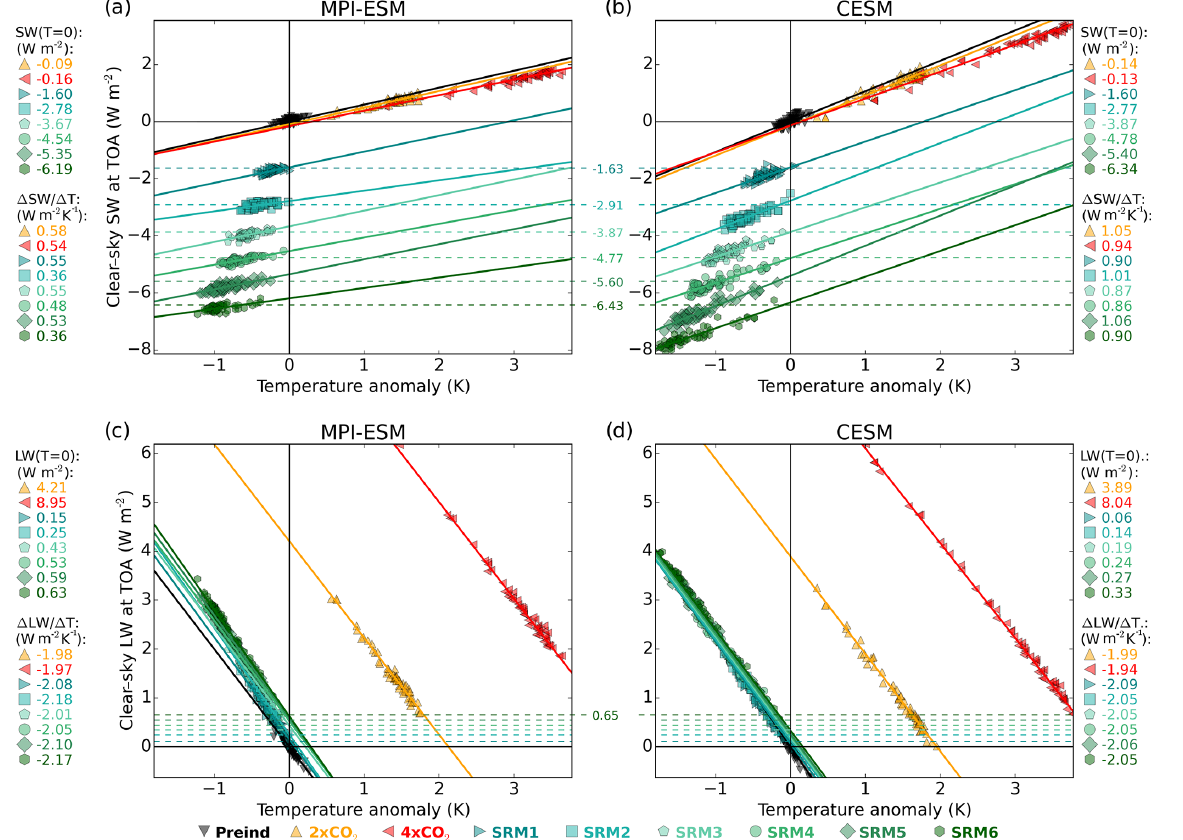
Figure 2. Gregory plots of the shortwave radiative flux change (clear-sky conditions) with (a) MPI-ESM and (b) CESM, as well as of the longwave radiative flux change (clear-sky conditions) with (c) MPI-ESM and (d) CESM. Markers indicate a single-year global mean value in one ensemble member, and solid lines are linear fit lines. Dashed lines show aerosol clear-sky radiative forcing in ECHAM-HAMMOZ, with numerical values shown in the middle. Corresponding radiative forcing – the intersection of the linear fit and the y axes ( T = 0) – in MPI-ESM and CESM is shown at the top, and the slope of the linear fit is at the bottom of the legends next to the panels. Origin represents zero temperature and clear-sky radiative flux anomaly compared to the Preind